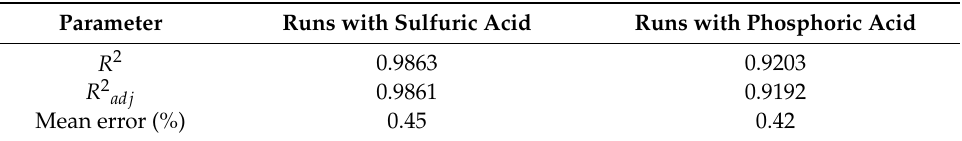
Table 7. Statistical parameters for the overall